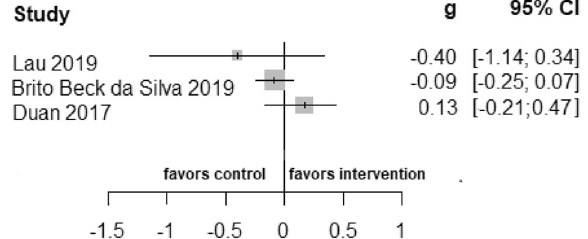
Fig. 5 Summary of culturally adapted IMI of health promotion vs. passive controls. Due to few numbers of studies (two studies reported data in the long-term, two in the short-term, while one study reported dichotomous outcome) comparing culturally adapted IMI to a passive control group, meta-analytic pooling did not perform.